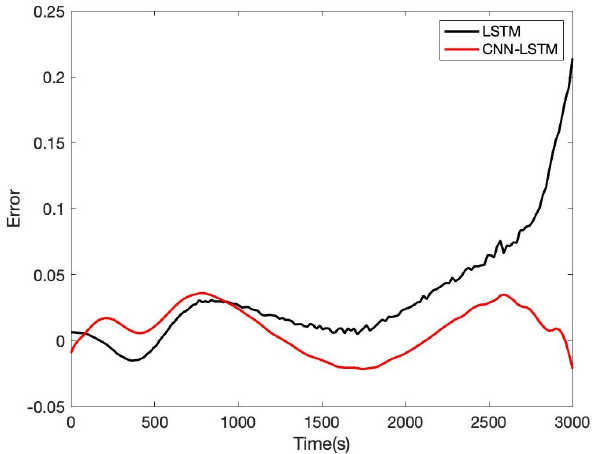
Figure 20. Battery SOE prediction error of